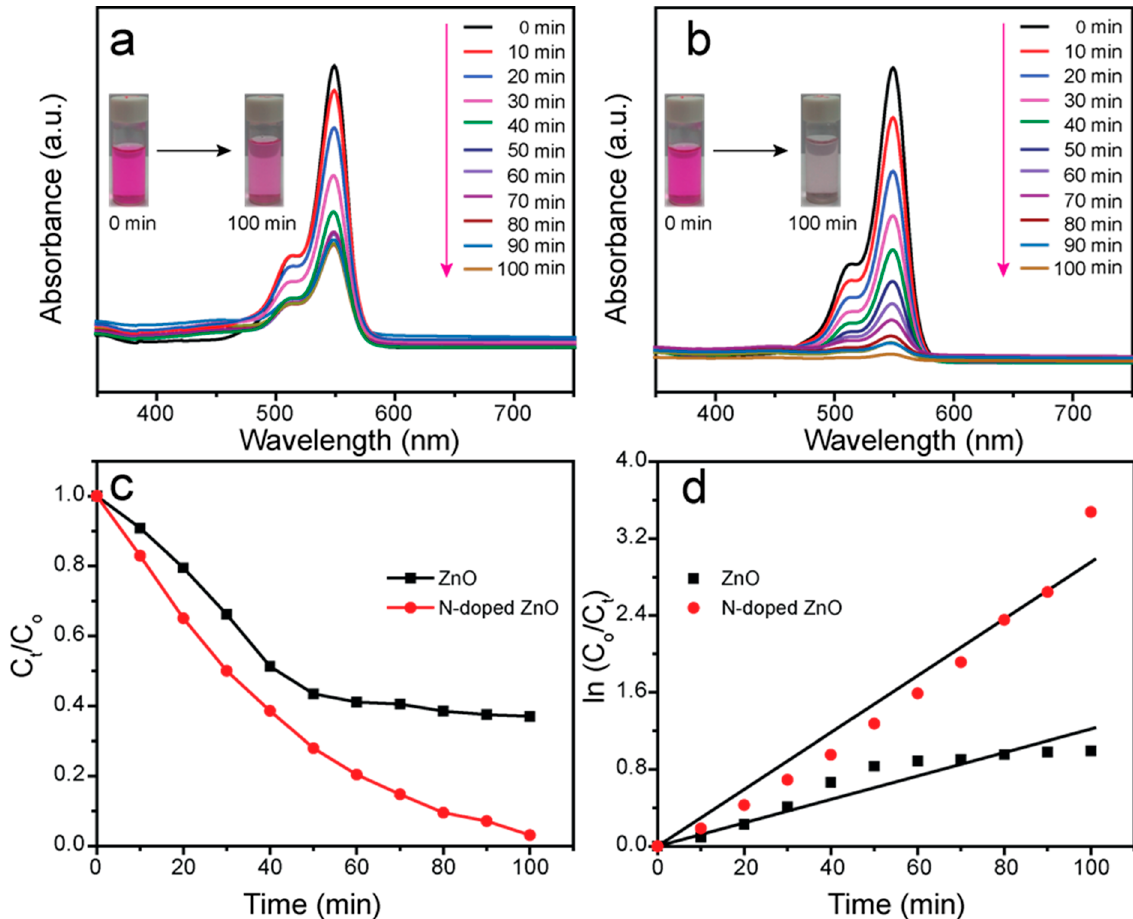
Figure 7. UV–vis absorbance spectra for the decomposition of RB dye in the presence of ( a ) ZnO and ( b ) N-doped ZnO (each inset shows the color variation of RB dye before (0 min) and after (100 min) photocatalytic reaction); ( c ) photodegradation activity as a function of time ( d ) and their corresponding kinetics.